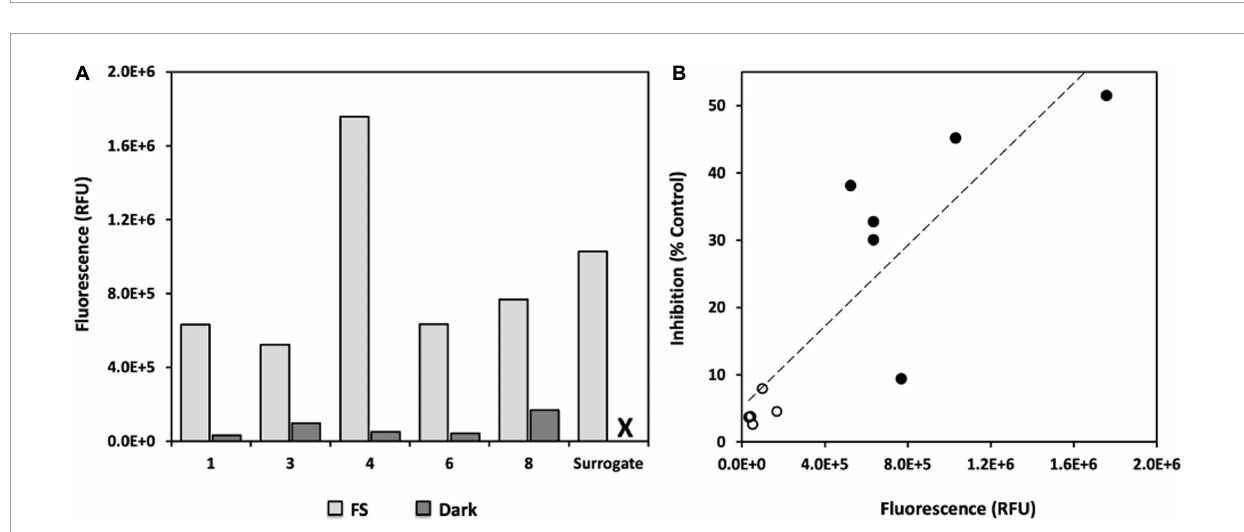
FIGURE5 Fluorescence of WAFs after exposure of 8 days of sunlight (or dark incubation for 8 days). (A) FS (light gray) and dark (dark gray) WAF fluorescence (ex. 365 nm, emiss., 410–600 nm) measured for each pooled WAF preparation and reported as relative fluorescence units (RFU) after subtracting the background fluorescence of the sterile seawater used to prepare WAFs; X = no fluorescence data for surrogate WAF prepared in the dark as sample was lost prior to analysis. (B) Correlation of bacterial production inhibition with WAF fluorescence. Inhibition of bacterial production ( 3